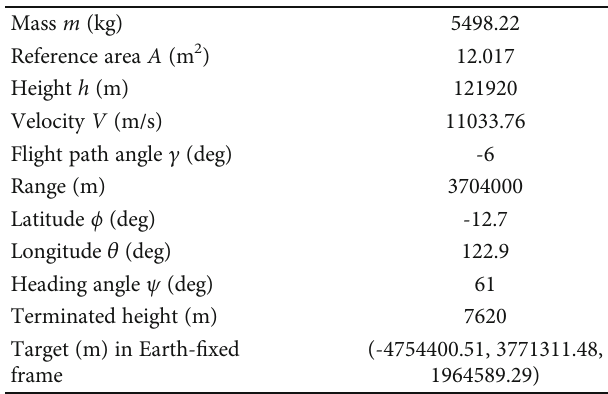
Table 2: Initial conditions, physical characteristics, and target on Earth [1,